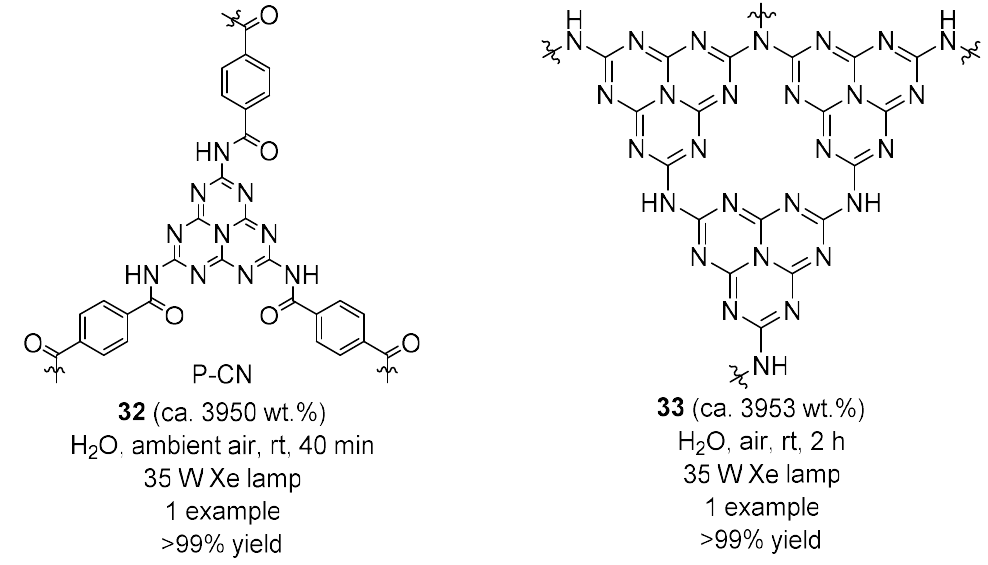
Figure 4. Results obtained in the photo-oxidative aromatization of the Hantzsch ester, leading to 20 catalyzed by 32 and 33 .